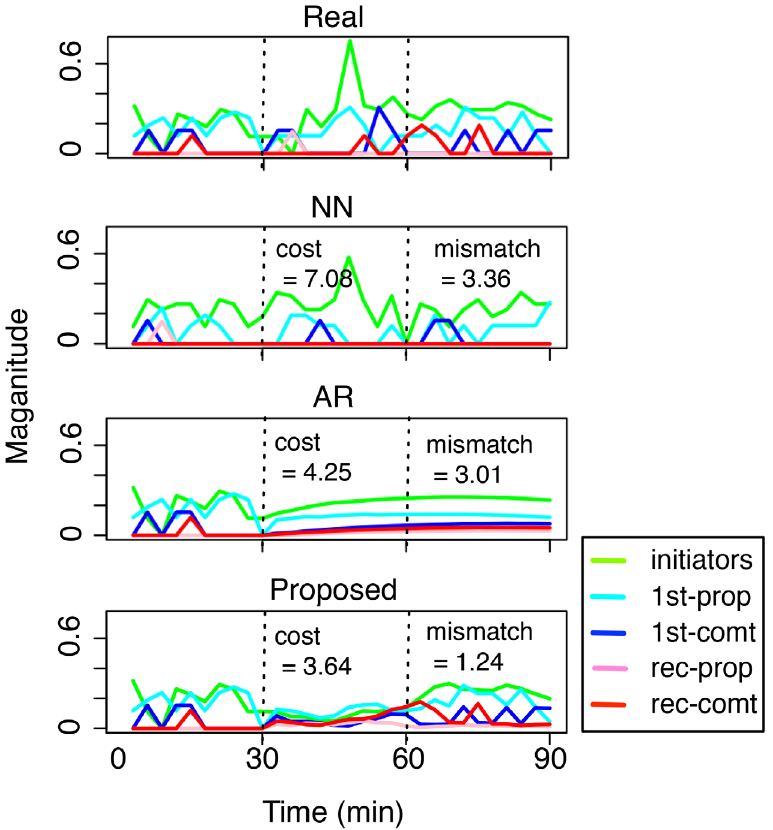
Fig 5. Case study: real versus the suggested dynamics using different methods. A good solution is characterized by low cost (during t 2 [30, 60]) and low mismatch (during t 2 [60, 90]). The X-axis denotes time (in minutes) and the Y-axis denotes the normalized number of different types of